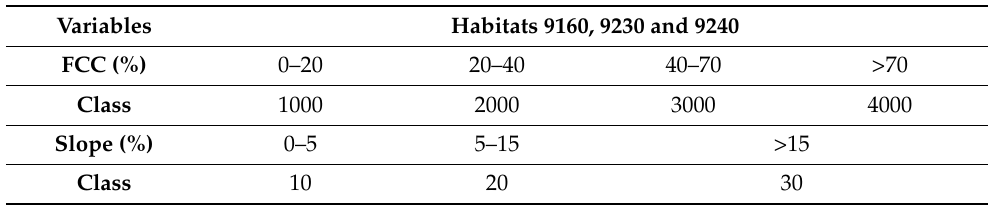
Table 1. Ranges established for the variables FCC (%) and slope (%). Additionally, 9160 is Quercus robur habitat, 9230 is Quercus pyrenaica habitat, and 9240 is Quercus faginea habitat.